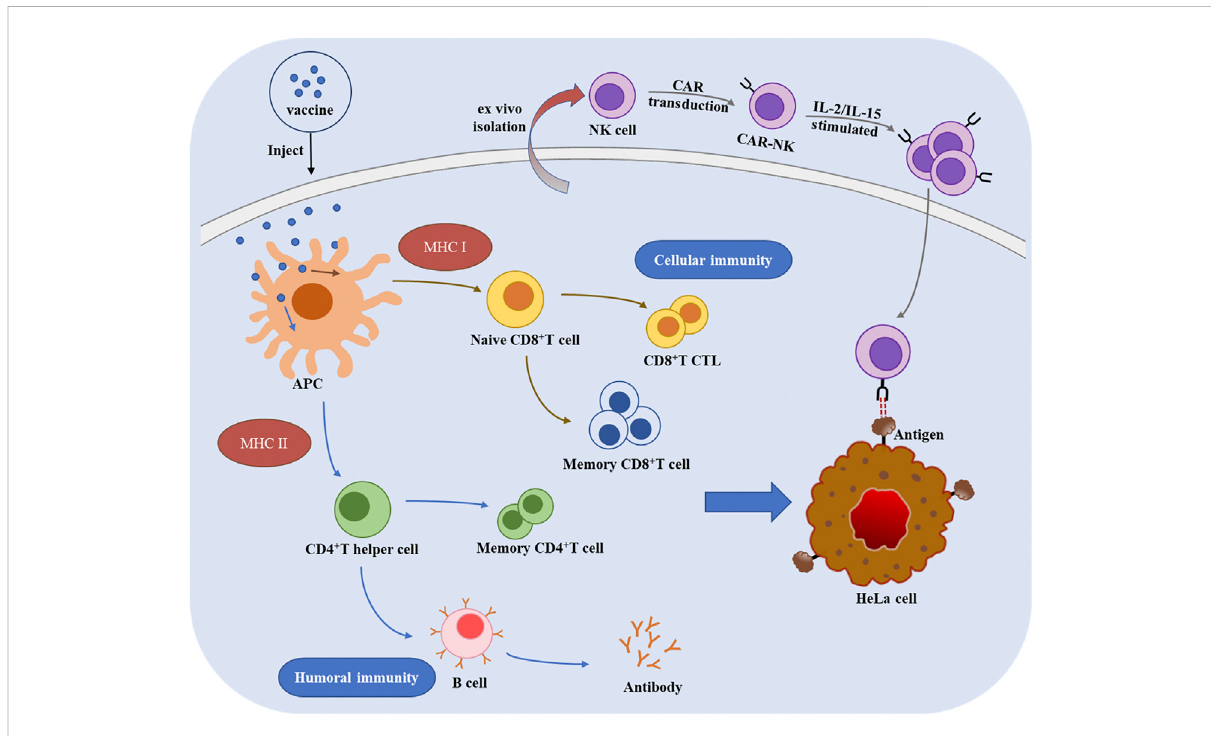
FIGURE 1 The mechanisms of therapeutic vaccines and adoptive cell therapy for cervical